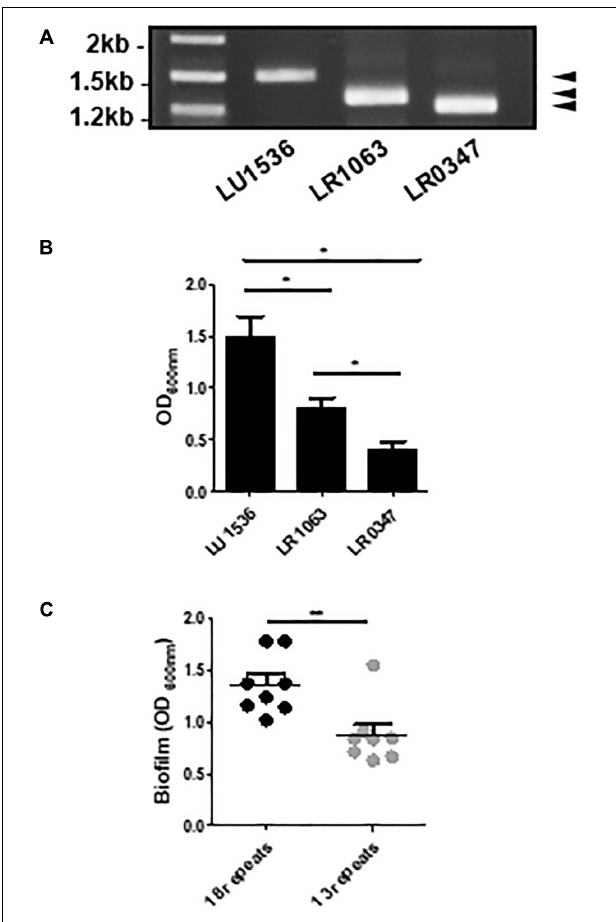
FIGURE 5 | The number of Lcl collagenous repeats is correlated with biofilm production in L. pneumophila clinical isolates. (A) PCR amplification of lcl in the indicated L. pneumophila clinical isolates visualized by agarose gel electrophoresis. (B) Biofilm formation of 2 days old biofilms quantified by crystal violet of the indicated L. pneumophila clinical isolates. (C) Biofilm formation of 2 days old biofilms of L. pneumophila clinical isolates containing 18 and 13 repeats. Eight different strains were included per group and are indicated in Table 2 . ∗ and ∗∗ denotes p < 0.05 and p < 0.01, respectively, by one-way